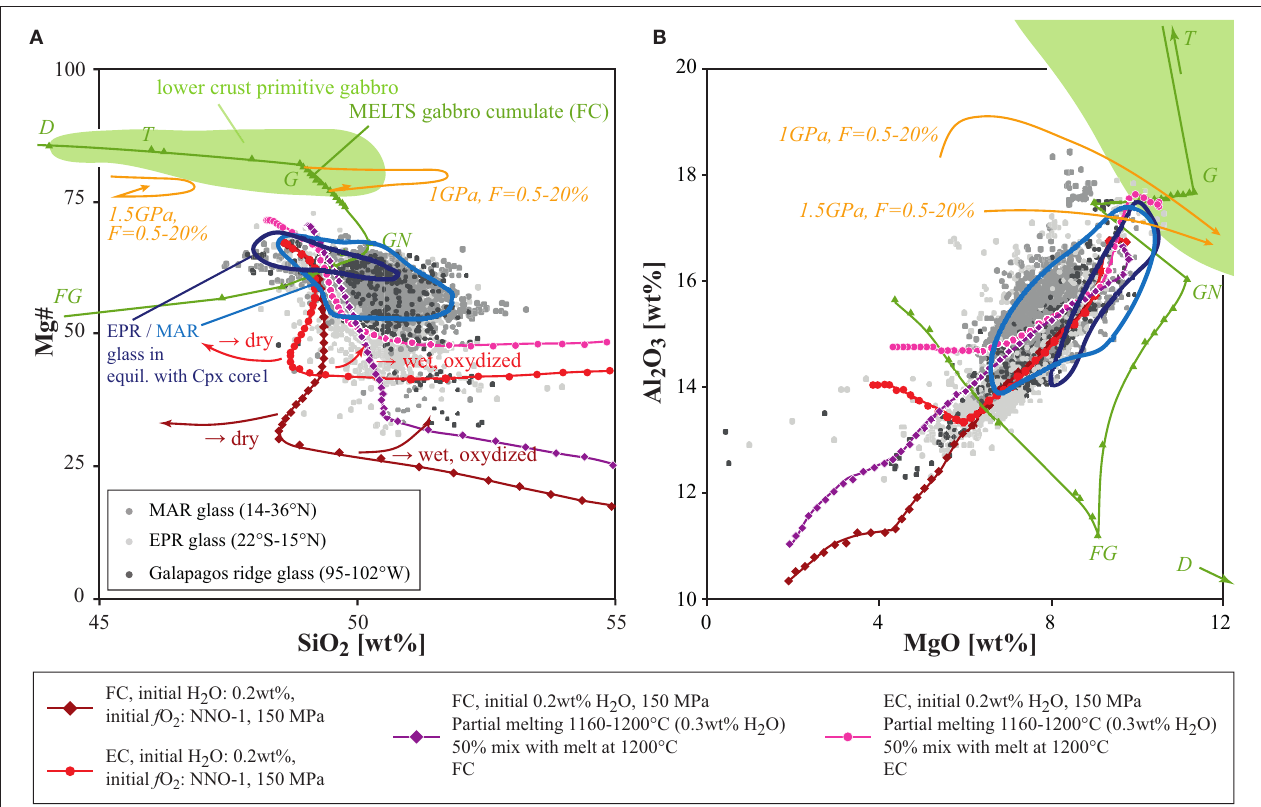
Figure 8 | Effect of gabbro cumulate assimilation on mantle-derived melt chemistry, with (A) Mg# vs SiO 2 and (B) Al 2 O 3 vs MgO. MORB glass [database from Gale et al. (2013), and PetDB, (Lehnert et al., 2000)] sampled along Mid Atlantic Ridge, East Pacific Rise and Galapagos rift axes, close to Kane Megamullion and Hess Deep, are shown. Spinel lherzolite partial melting arrows show the chemical evolution of mantle-derived melt upon pressure (1 to 1.5 GPa) and partial melting ( F = 0.5 to 20%) increases [pMELTS by Ghiorso et al. (2002); based on KLB-1 spinel lherzolite of Hirose and Kushiro (1993), see composition in Table A.3 ] [note: partial melting of olivine-poor lherzolite produces a melt with lower Mg#, as seen in experiments by Hirose and Kushiro (1993)]. The dunite ( D ), troctolite ( T ), gabbro ( G ), gabbronorite ( GN ) and ferrogabbro ( FG ) cumulates calculated using MELTS [fractional crystallization of primitive MOR glass (see Table A.3 ) at NNO-1, 0.2 wt.% H 2 O and 0.15 GPa] reproduces the lower oceanic crust gabbro primitive cumulate from Gillis et al. (2014a). The melt liquid lines of descent, assuming pure fractional crystallization (FC) and equilibrium crystallization (EC), show early MgO and Al 2 O 3 decreases and subsequent SiO 2 increase due to magnetite crystallization. At higher water content and/or oxygen fugacity, the melt becomes SiO 2 -rich at high Mg#. Gabbro partial melting and hybridization with hot mantle-derived melt results in little but distinct physical and chemical modifications of the percolating primitive MOR melts [but may be confused with other parameters (e.g., water content, oxygen fugacity, pressure, equilibrium vs. fractional crystallization)]. The clinopyroxene core1 parental magma chemistry was determined using the major element chemistry of glass sampled close to Kane Megamullion and Hess Deep and whose TiO 2 , Cr 2 O 3 , and REE (Ce/Sm and Sm on Figure 9 ) are equivalent to the calculated core1 parental magma (see text for discussion of the partition